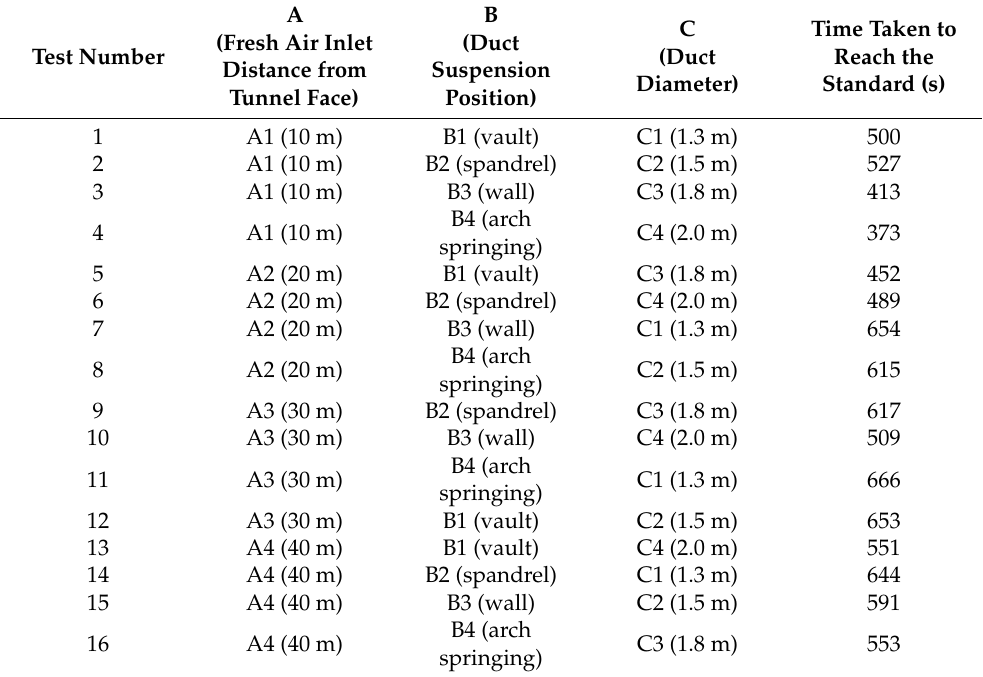
Figure 3. CO changes with time after ventilation. Table 5. Orthogonal experimental results.